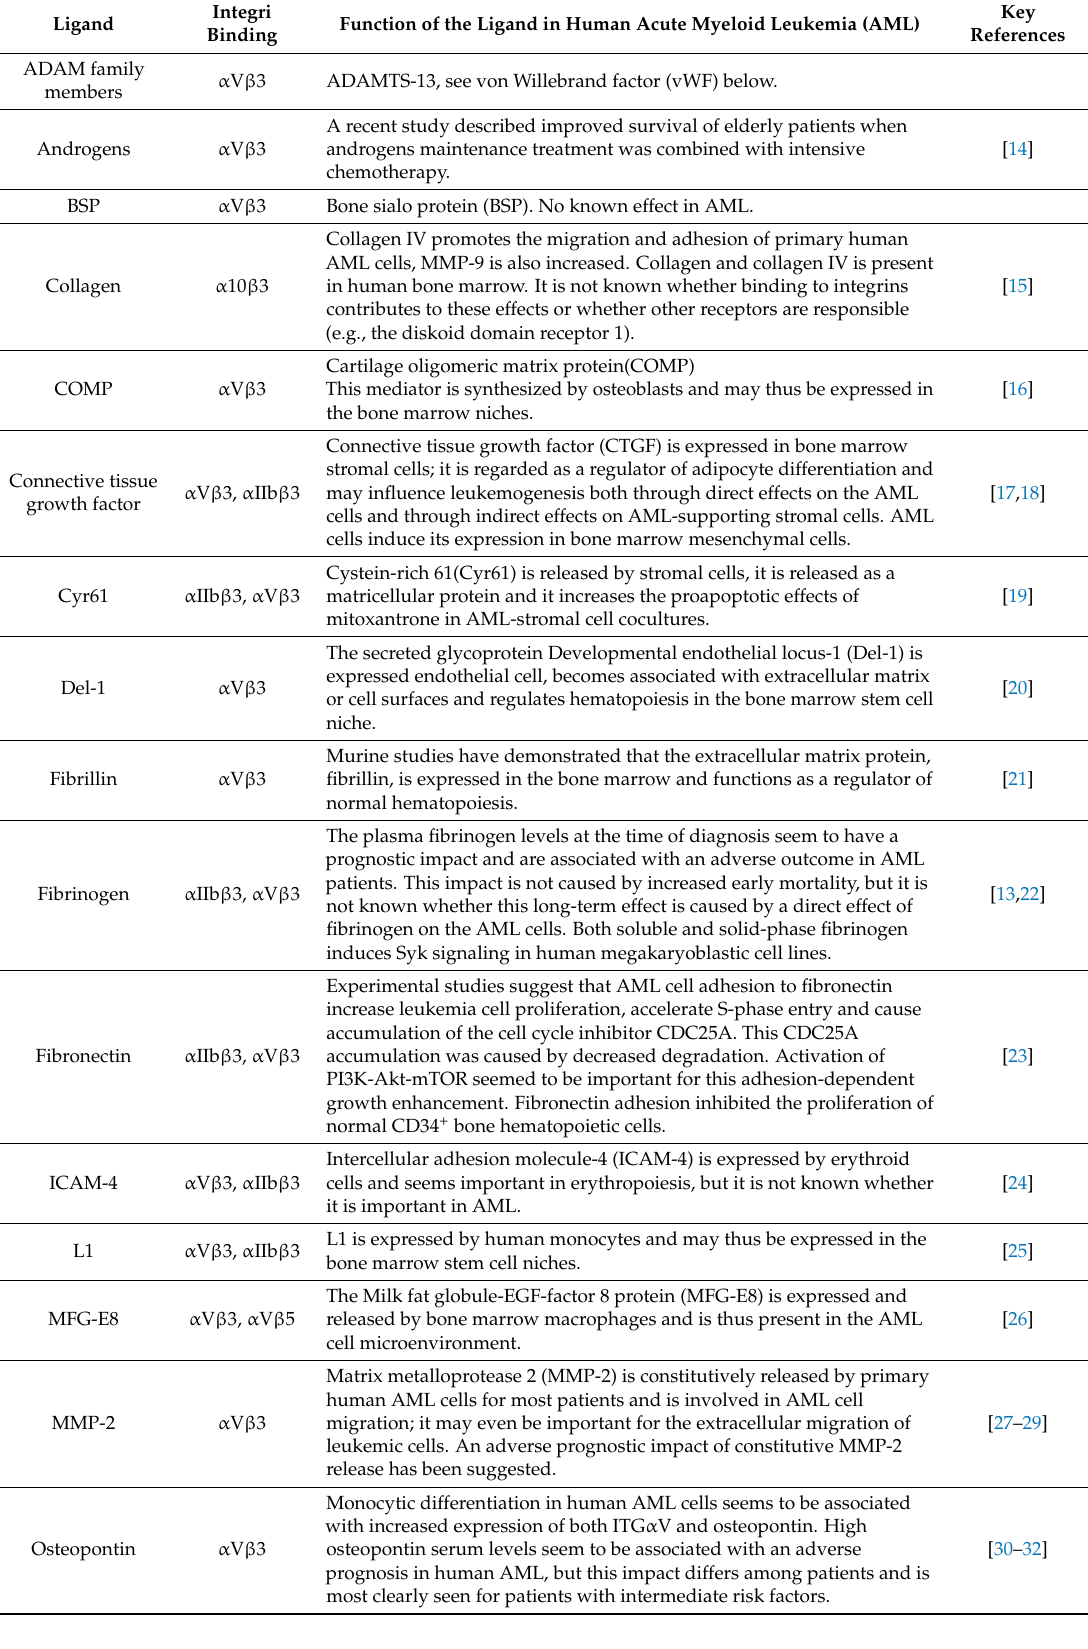
Table 1. Classification of β 3 integrin ligands and an overview of the importance ligands, their important functions and their integrin binding; for additional details see [9] and the Gene database [13–40]. Integri Ligand